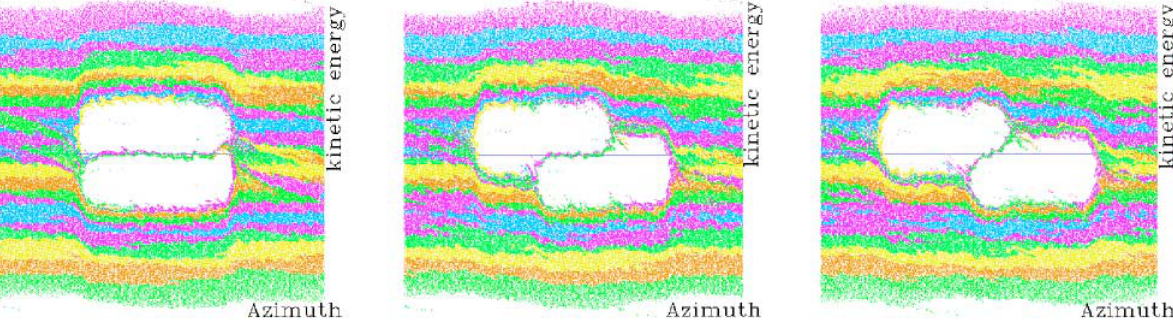
FIG. 27. (Color) Phase space scatter plots (left to right) at 2 13.87 , 2 13.62 , and 2 13.49 ms, respectively. 5 3 10 12 protons, 2.2 3 10 5 macroparticles.